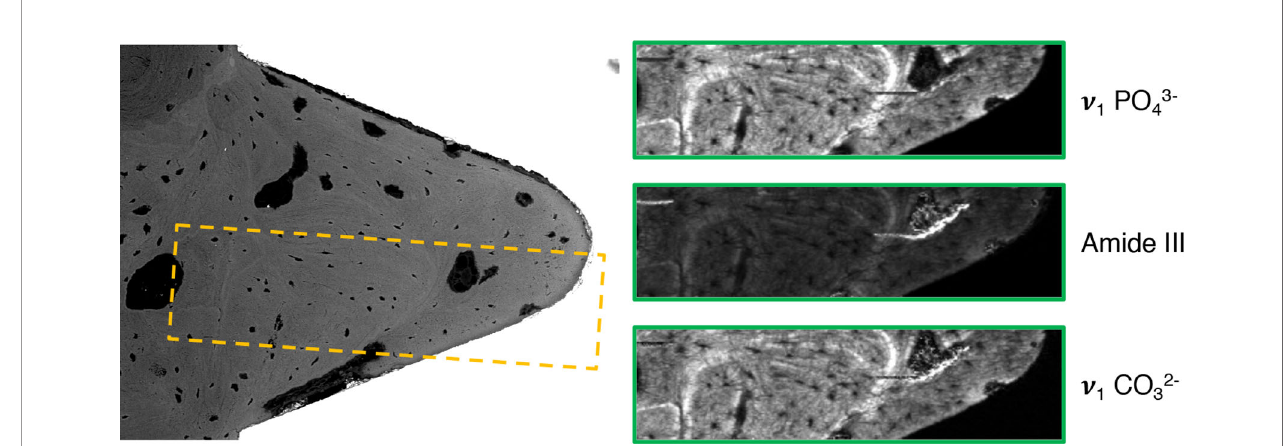
FIGURE 6 | Backscattered electron scanning electron microscopy (BSE-SEM) and Raman imaging corresponding to the yellow box, showing the distribution of phosphate (v 1 PO 3 − 4 ), collagen (Amide III), and carbonate (v 1 CO 2 − 3 ) within the implant